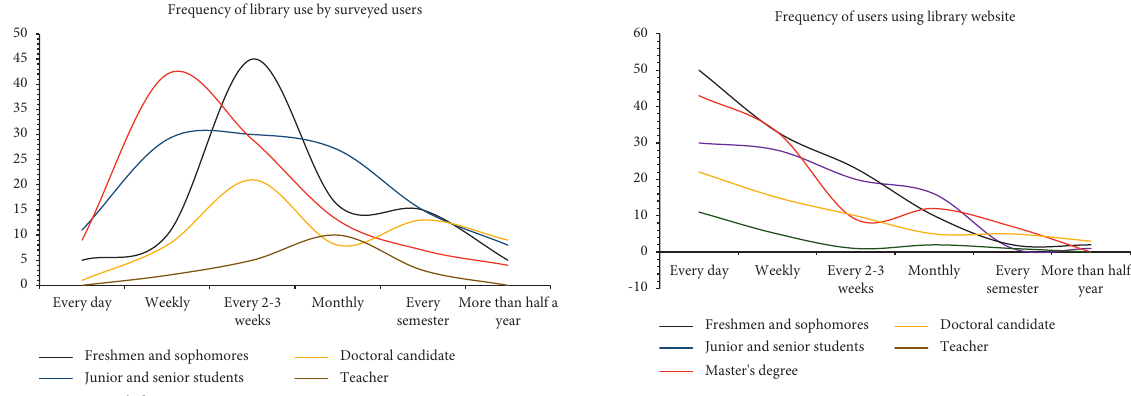
Figure 8: Frequency analysis of library and library website use by surveyed users.